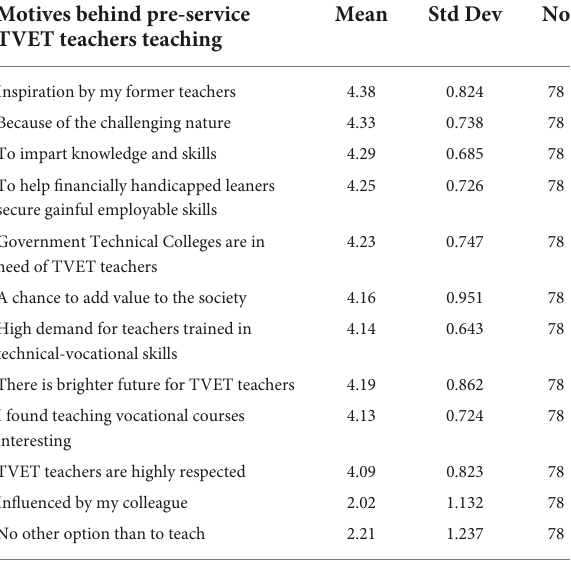
TABLE 1 Result of occupational decision motives behind pre-service technical vocational education and training (TVET)